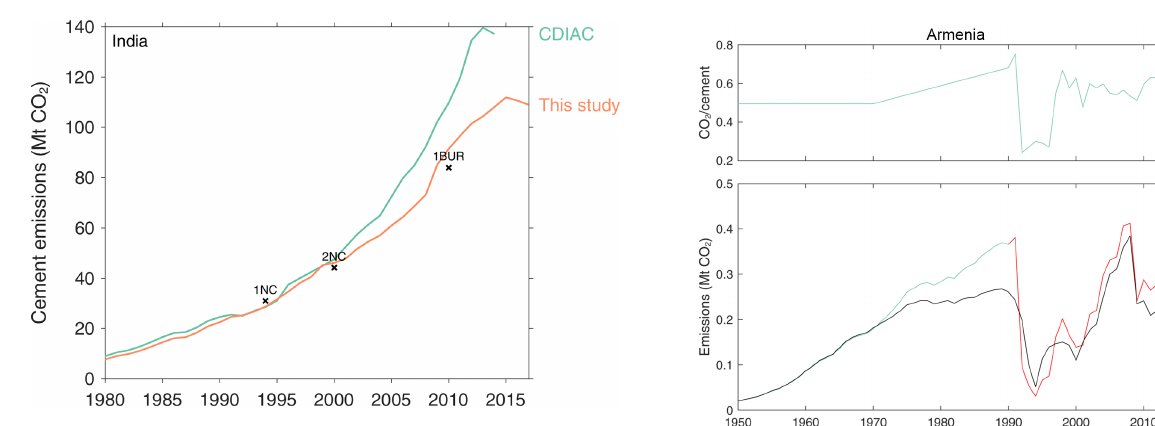
Figure C7. Revised cement emissions for India. 1NC: first National Communication; 2NC: second National Communication; 1BUR: first Biennial Update Report.